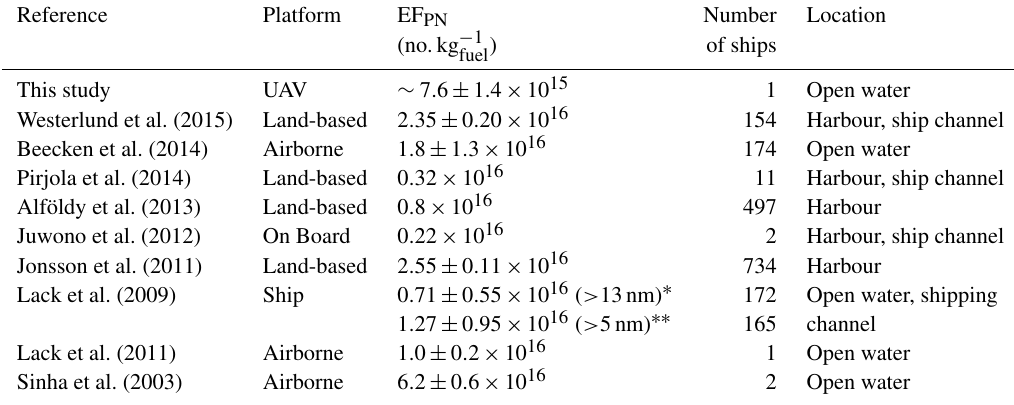
Table 3. Comparison of the emission factor for the RV Investigator found in this study with other relevant values found in the literature.